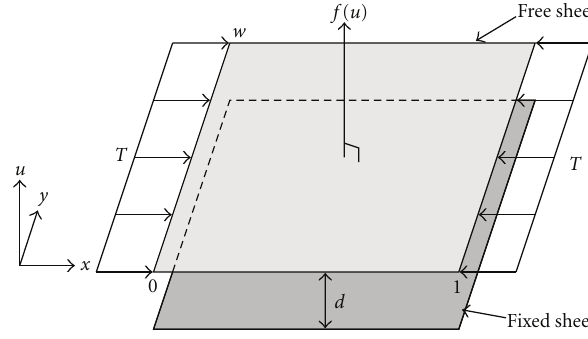
Figure 2: Schematic of the system of graphene sheets.